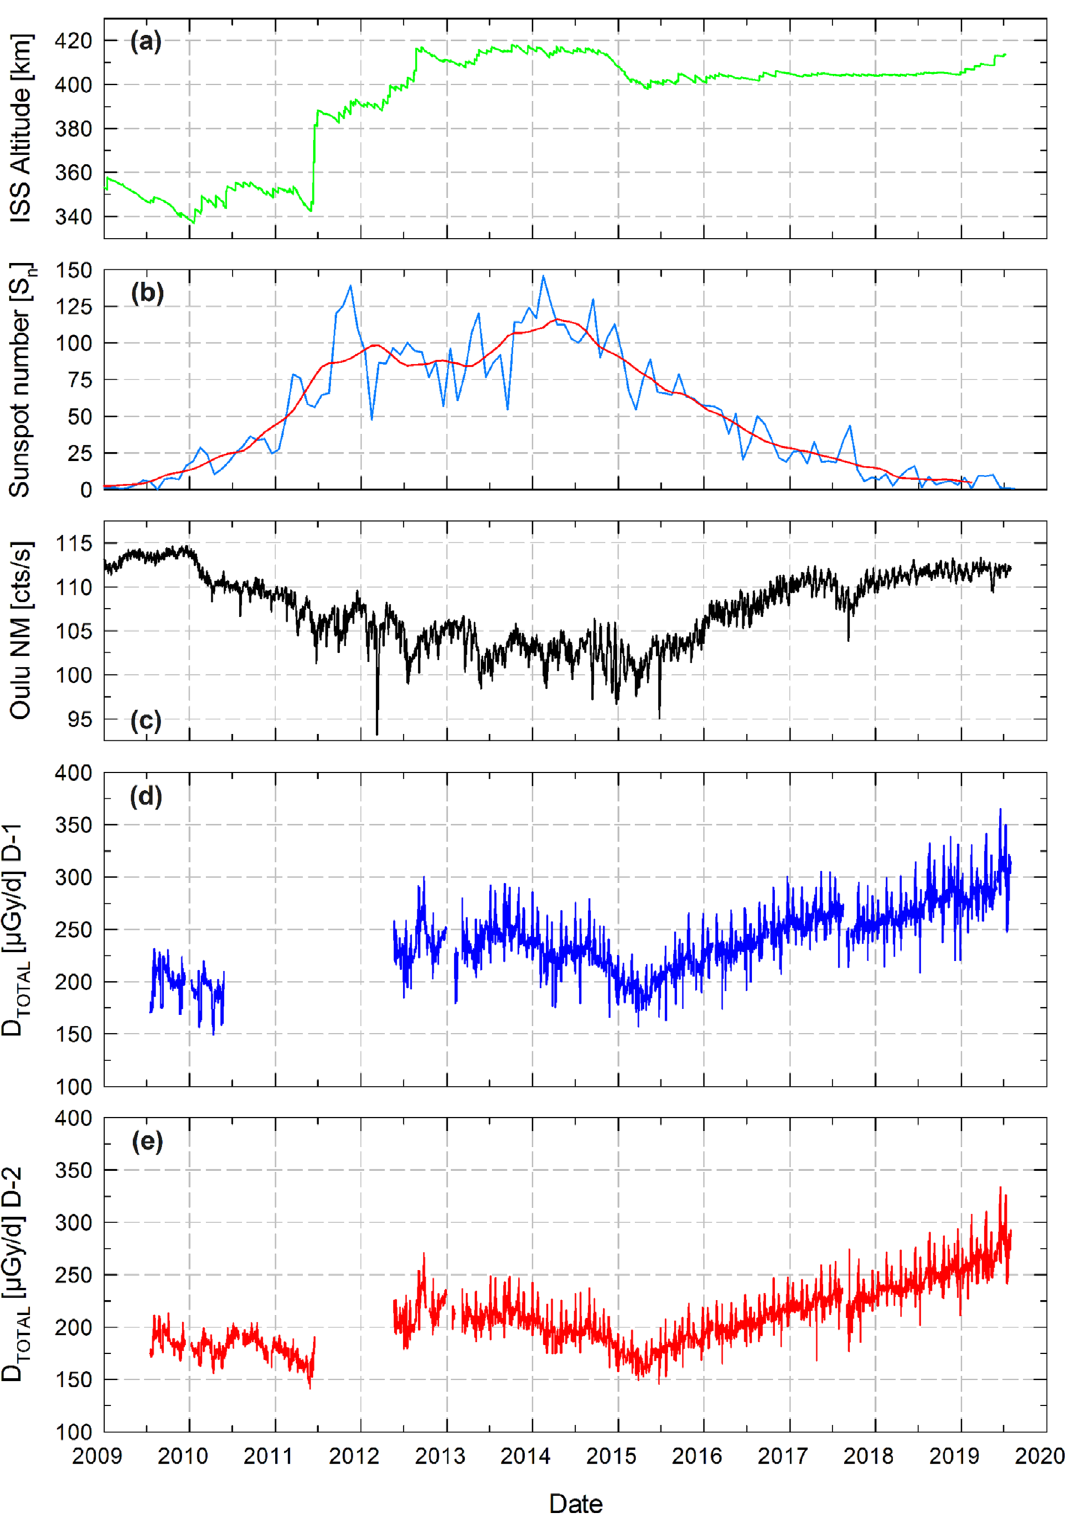
Fig. 2. (a) The altitude of the International Space Station from 2009 to 2019; (b) monthly (blue) and smoothed (red) sunspot numbers (data from: http://www.sidc.be/silso/data fi les); (c) Oulu NM count rate in counts/sec (data from: http://cosmicrays.oulu. fi /); (d) DOSTEL-1 (D-1) total absorbed daily dose rate; and (e) DOSTEL-2 (D-2) total absorbed daily dose